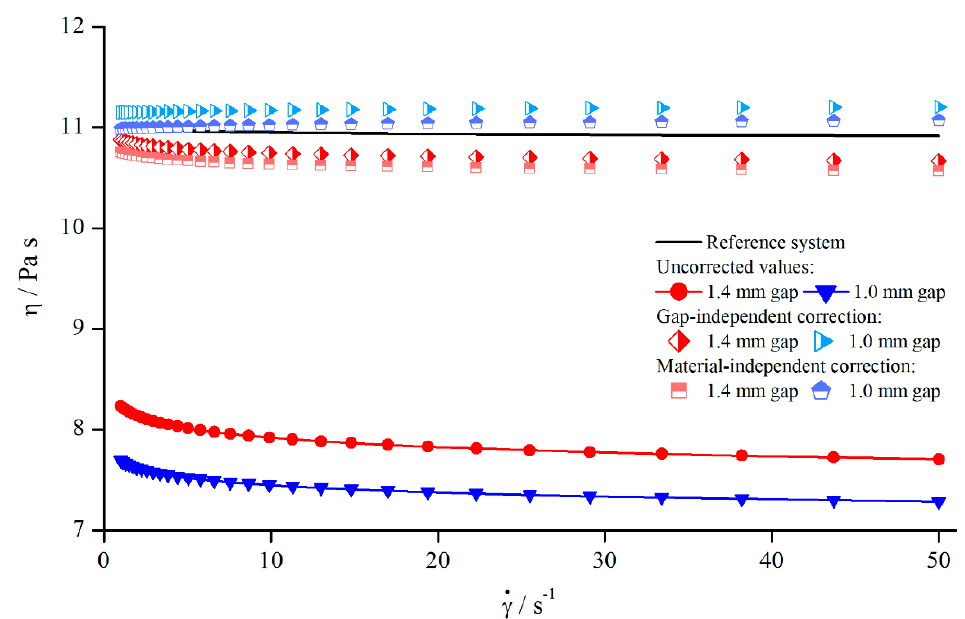
Figure 22. Uncorrected, corrected, and reference viscosities of 25 wt.% suspension, measured with columns (system 5).